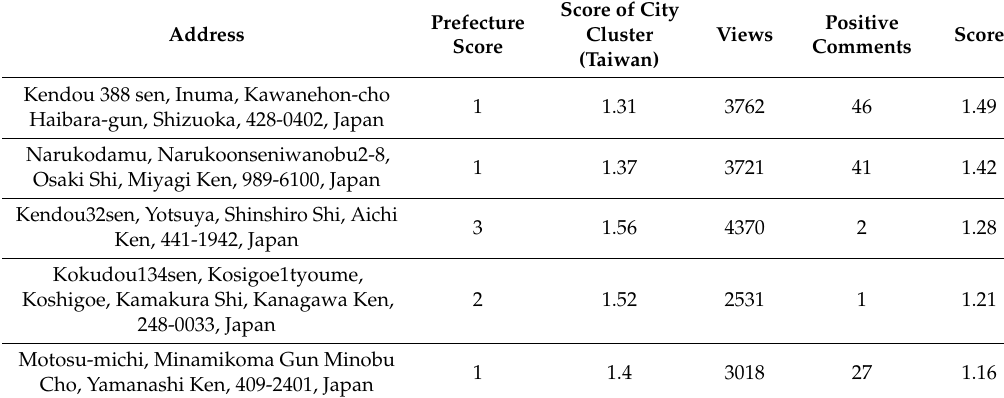
Table 9. Top 5 Taiwanese ranking results.